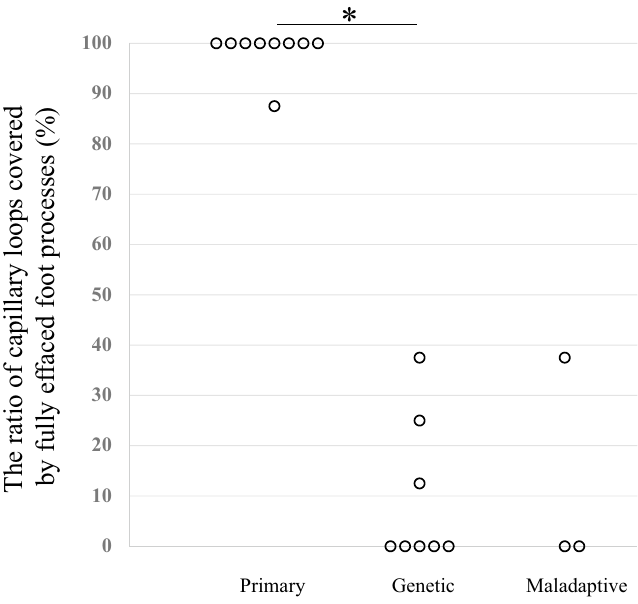
Figure 1. The degree of FPE (%FPE), shown as the percentage of capillary wall surface that was covered by podocyte foot processes uninterrupted by filtration slits. All patients with genetic FSGS (eight patients) showed segmental FPE ranging from 0 to 38%, while all patients with primary FSGS (nine patients) showed diffuse FPE ranging from 88 to 100%. Percentage of FPE was significantly higher in primary FSGS patients than in genetic FSGS patients ( p = 0.0003). Percentage of FPE of maladaptive FSGS (three patients) ranged from 0 to 38%.